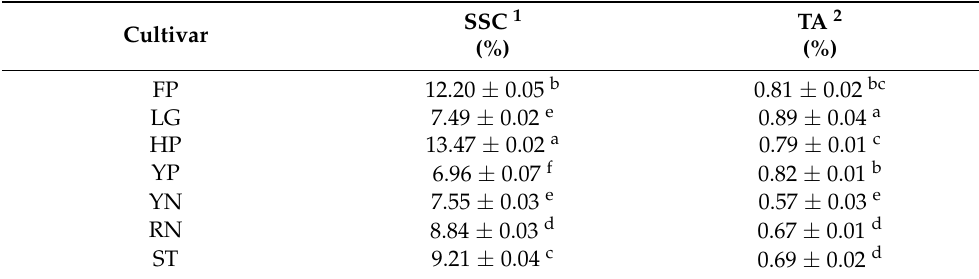
Table 1. The soluble solids content and titratable acidity of seven peach